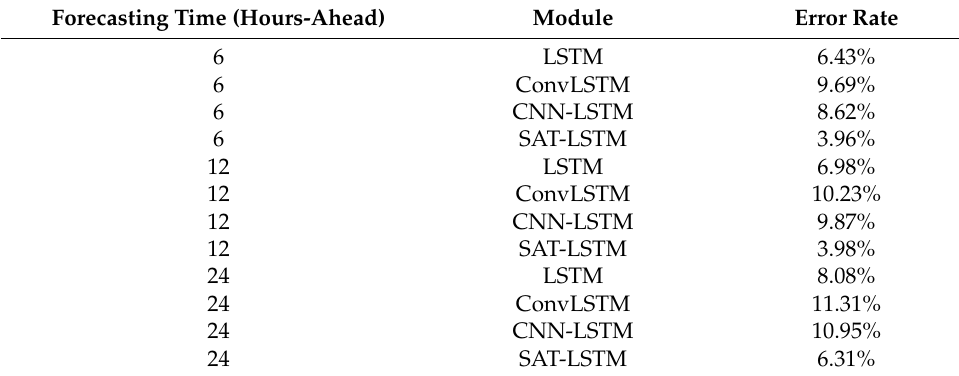
Table 3. Error Rate of the proposed models’ performance. Forecasting Time (Hours-Ahead)